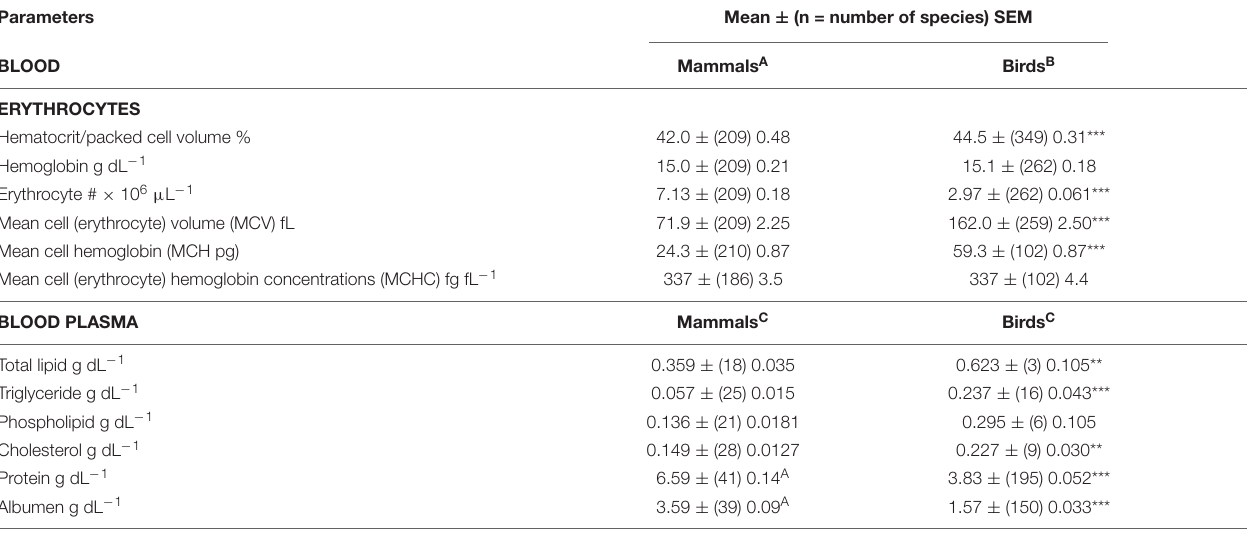
TABLE 1 | Blood parameters in avian and mammalian